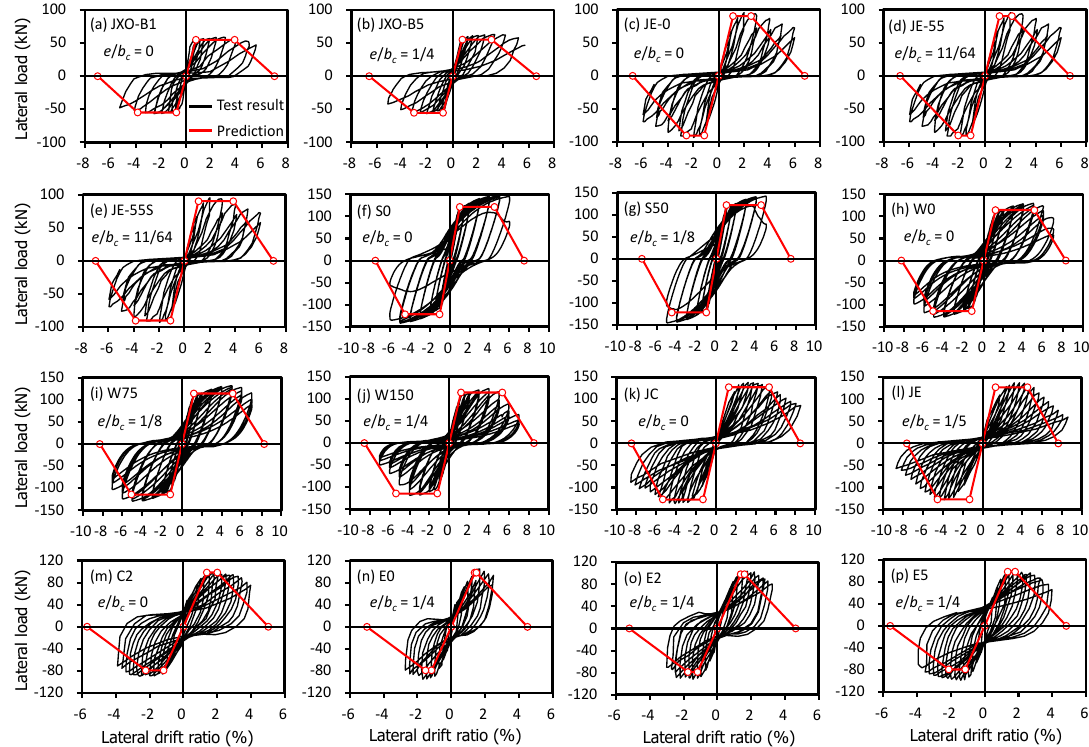
Figure 7. Comparison between test results and predictions with ACI 352R-02.